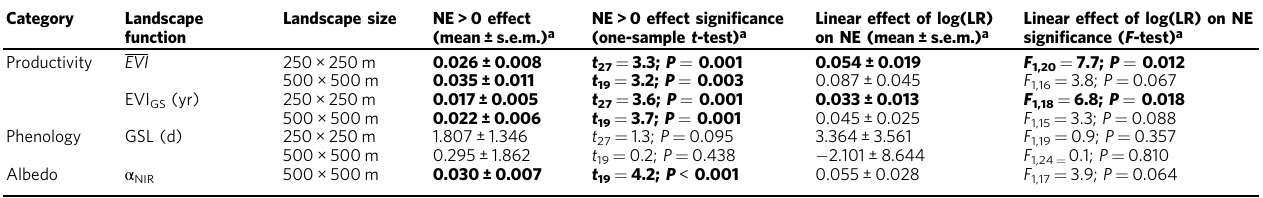
a Statistically signi fi cant results are highlighted in bold The fi rst test(NE>0)indicates whetherlandscapeplotswitha mixtureof land-covertypesperformedbetter thanlandscapeplotswithasingleland-covertype.Thesecondtest [lineareffectof log(LR)] indicateswhether NEincreasedwithlog-transformed landscaperichness[log(LR)].Productivity: growing-seasonmean enhancedvegetation index( EVI ),growing-season integratedenhanced vegetation index (EVI GS ); Phenology: growing-season length (GSL); Albedo: near-infrared range ( α NIR ); t : t -value with associated degrees of freedom; F : F -ratio with associated degrees of freedom; P : P -value ( n = 153 and 40 land-cover composition×block combinations with landscape richness>1 in 250×250m and 500×500m landscapes, In 250 × 250 m plots, log(LR) promoted the stability of average